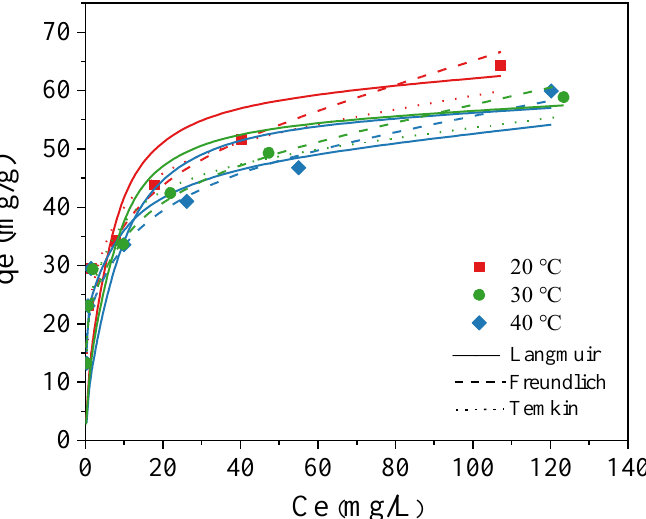
Figure 10. Langmuir, Freundlich, and Temkin adsorption isotherms fitting of LDHs@ANA composite for adsorption of MB. Table 4. Isotherm calculation parameters of MB absorbed on the LDH s @ANA composite.